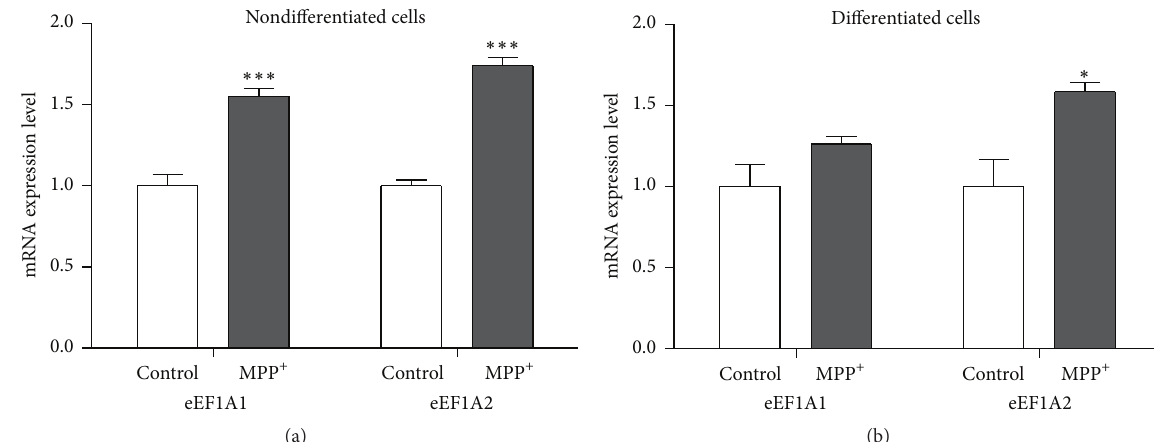
Figure 3: mRNA expression levels of eEF1A1 and eEF1A2 in nondifferentiated SH-SY5Y cells (a) and mRNA expression levels of eEF1A1 and eEF1A2 in differentiated SH-SY5Y cells (b). For neuronal differentiation, SH-SY5Y cells were treated with 10 𝜇 M retinoic acid for three days before exposure to MPP + . The control groups for nondifferentiated and differentiated SH-SY5Y cells were treated with the same medium without MPP + . Real-time quantitative PCRs were repeated three times in triplicate measurement. Data are expressed as relative to a control and shown as mean ± SEM. ∗ indicates 𝑃 < 0.05 and ∗ ∗ ∗ indicates 𝑃 < 0.001 versus control of each group.